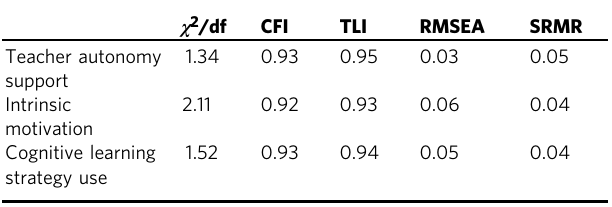
Table 1 Fit indices from con fi rmatory factor analyses of each section the variables